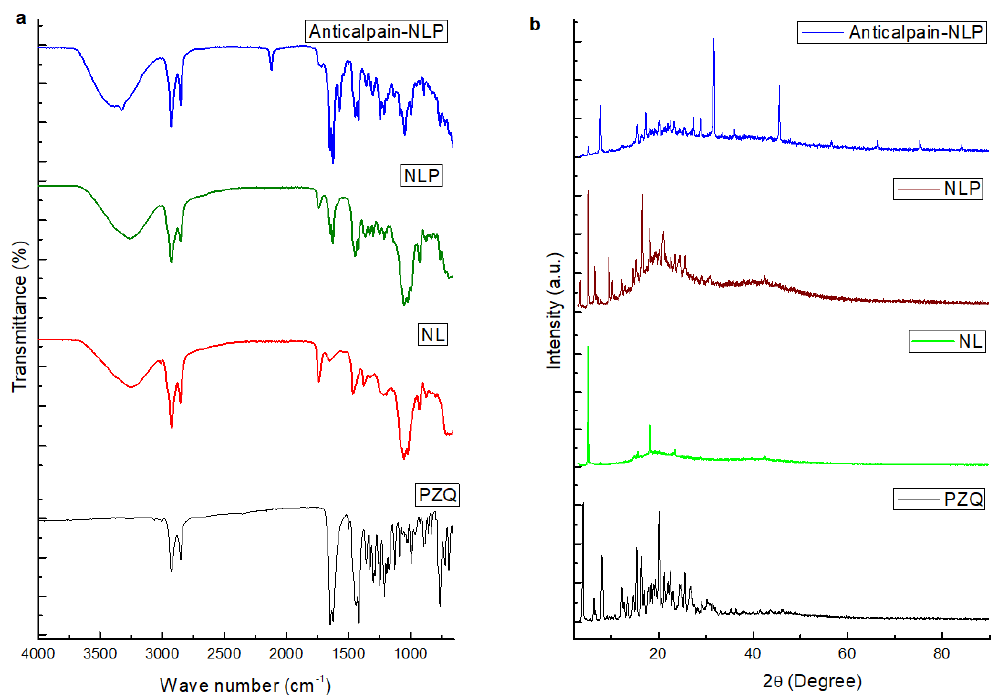
Figure 3. ( a ) FTIR spectra of PZQ, NL, NLP, and anti-calpain-NLP. The FTIR spectrum for the PZQ showed vibration peaks at the wavenumbers 2929.49 cm − 1 and 2852.52 cm − 1 . NL displayed a broad FTIR spectrum band at wavenumber 3256 cm − 1 , and two bands were observed at wavenumbers 2924 cm − 1 and 2853 cm − 1 . In NLP, the absorption peaks that corresponded to the peaks of PZQ disappeared, and the carboxyl group absorption at 1739 cm − 1 stretched became weak and the peak absorption at 1640 cm − 1 became stronger. Anti-calpain-NLP presented an absorption band at 1851 cm − 1 and absorption at 1739 cm − 1 , while there is a slight shift and a very high peak absorption at 1624 cm − 1 . This indicates that amide(-NH 2 ) bending vibrations are formed during the covalent binding of the anti-calpain antibody; ( b ) P-XRD images of PZQ, NL, NLP and anti-calpain-NLP.